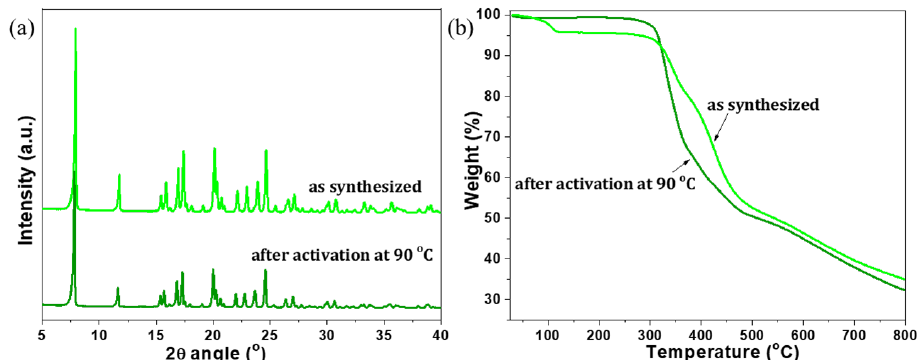
Figure 3. ( a ) XRPD patterns and ( b ) TGA curves of QUF-001, as synthesized and after activation at 90 °C for 16 h.